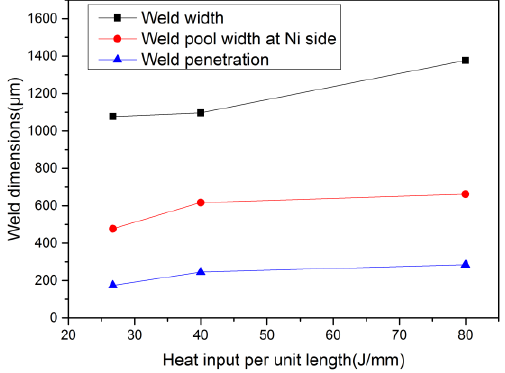
Figure 8. Weld dimensions under different heat